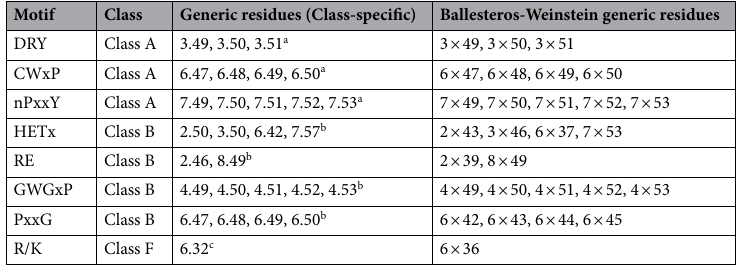
Table 2. Investigated motifs, and their residues as noted by their generic residue numbering, both class-specific and Ballesteros-Weinstein. a Class-specific generic residue numbering scheme: Ballesteros- Weinstein 8,54 . b Class-specific generic residue numbering scheme: Wootten 8 . c Class-specific generic